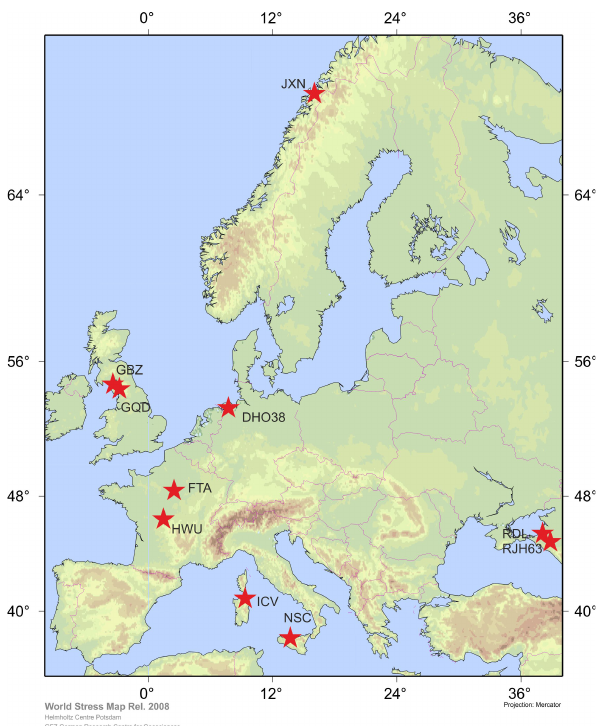
Fig. 11. Positions of some of the most intensive European VLF transmitters (cf. Fig. 12): JXN (16.4kHz; 66 ◦ 58 0 N, 13 ◦ 52 0 E; Norway), GBZ (19.6kHz; 54 ◦ 54 0 N, 3 ◦ 16 0 W; United Kingdom),